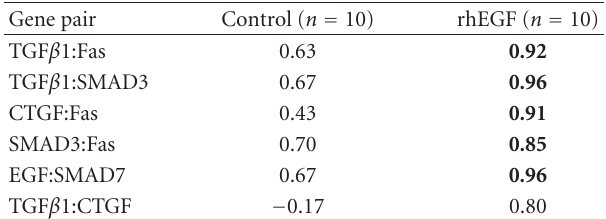
Table 4: SW1353 chondrosarcoma cell cultures respond to rhEGF (1ng/mL for 1h) stimulation under serum-free culture conditions. Significant correlations are in